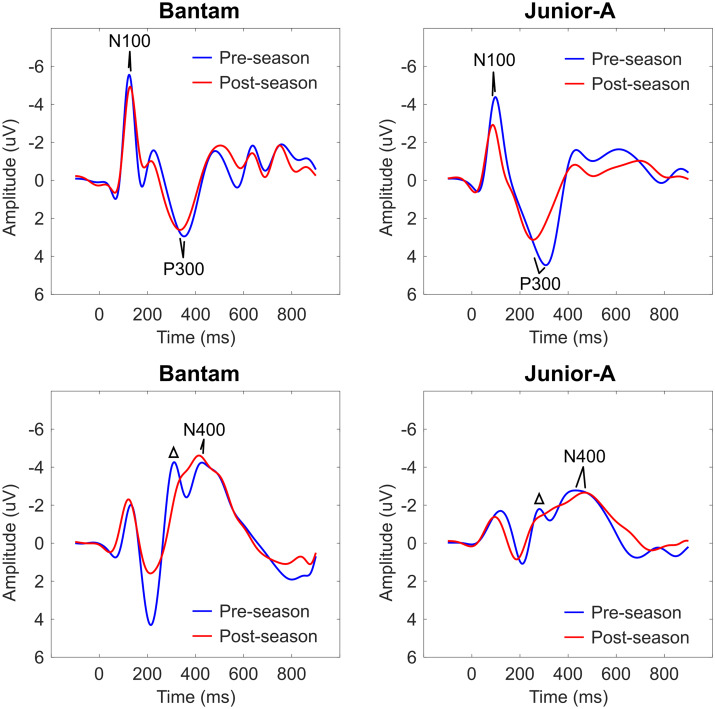

ERP waveforms. Group-averaged ERP Waveforms showing Bantam (left column) and Junior-A (right column) groups and brain vital sign responses to Deviant tones (top row) and Incongruent Words (bottom row). Waveform changes in the phonological mismatch negativity (Δ), which precedes the N400.